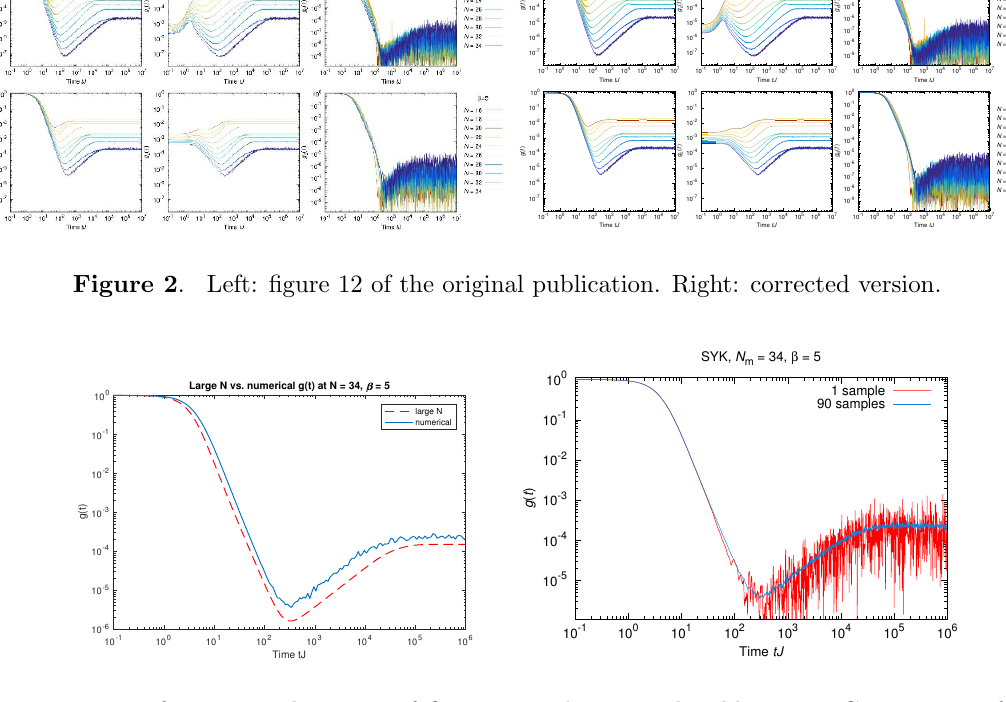
Figure 3 . Left: corrected version of (cid:12)gure 7 in the original publication. Comparison of the large- N estimate against the corrected data. Right: corrected version of (cid:12)gure 10 in the original publication. Note that the di(cid:11)erence in the appearance of the graph comes mainly from the number of data points and the scale, rather than from using the correct Z ( (cid:12) ) instead of Z ( (cid:12); t 0 = 0 : 1).